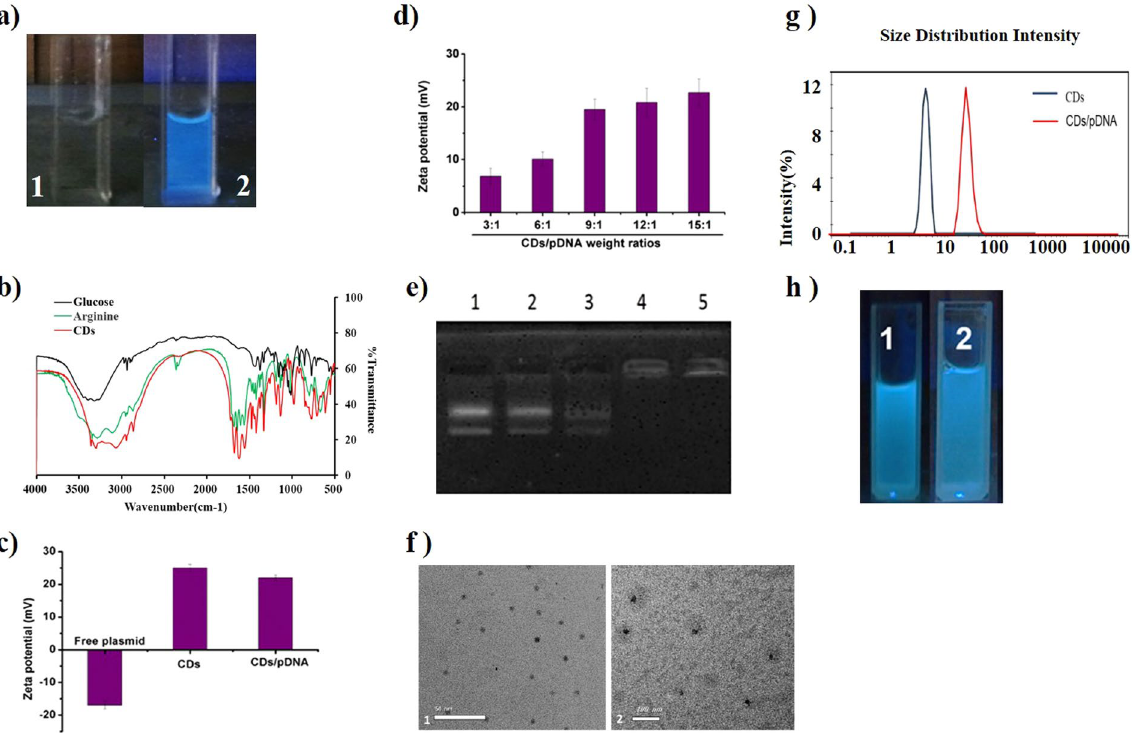
Figure 1. Characterization of CDs and CDs/pDNA complexes. ( a ) Aqueous CDs solutions under UV light at 365 nm: 1, double distilled water; 2, CDs solution; ( b ) FT-IR spectra of glucose, arginine and CDs; ( c ) Zeta potential of free plasmid, CDs and CDs/pDNA complexes; ( d ) Zeta potential of CDs/pDNA complexes prepared at CDs/pDNA weight ratios of 3:1, 6:1, 9:1 12:1, and 15:1; ( e ) Agarose gel electrophoresis: CDs/pDNA complexes at different weight ratios (1:1, 3:1, 6:1, 9:1, and 12:1, from left to right); ( f ) TEM images: 1, CDs; 2, CDs/pDNA complexes; ( g ) Particle size distribution of CDs and CDs/pDNA complexes (2:1); ( h ) Aqueous CDs before (1) and after (2) complexation with pDNA under UV light at 365 nm. Values are the means ± SD of three repeated